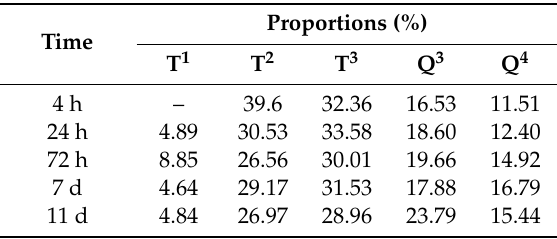
Table 2. Deconvolution of 29 Si MAS-NMR spectra for polysiloxane hybrids synthesized from the [TMOS] / [MPTS] mixture with dried at 65 ◦ C for di ff erent